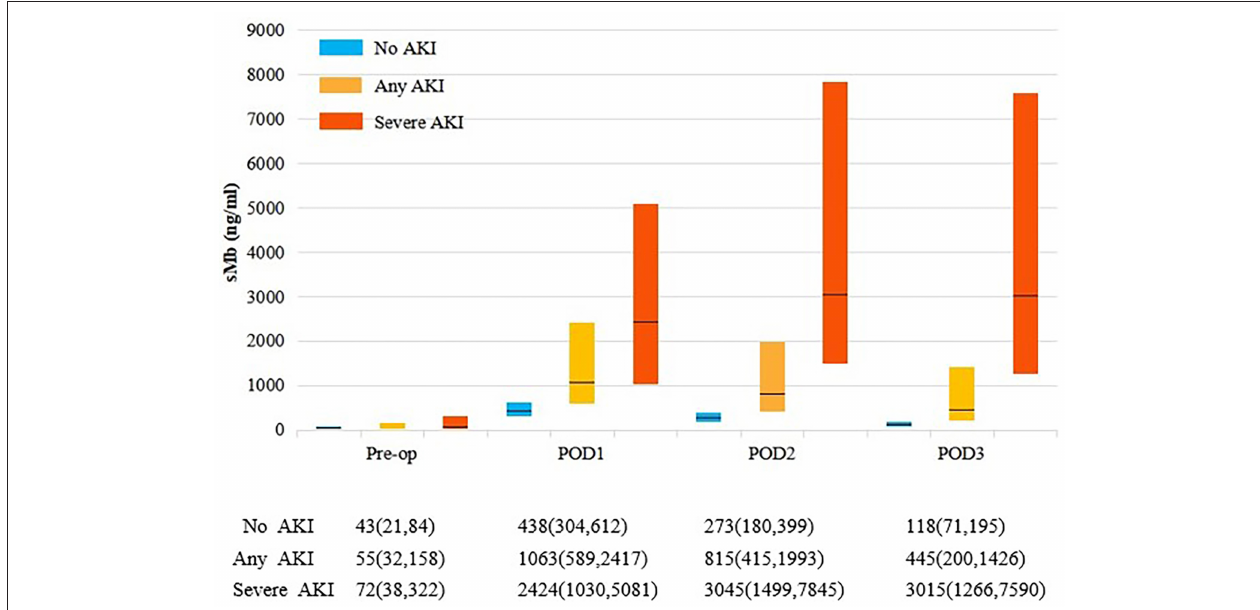
FIGURE 1 | Perioperative sMb levels by AKI status. Each bar represents the interquartile range (25th percentile to 75th percentile) and the black line represents the median. Any AKI is KDIGO stage 1 or higher. Severe AKI is KDIGO stage 2 and 3.